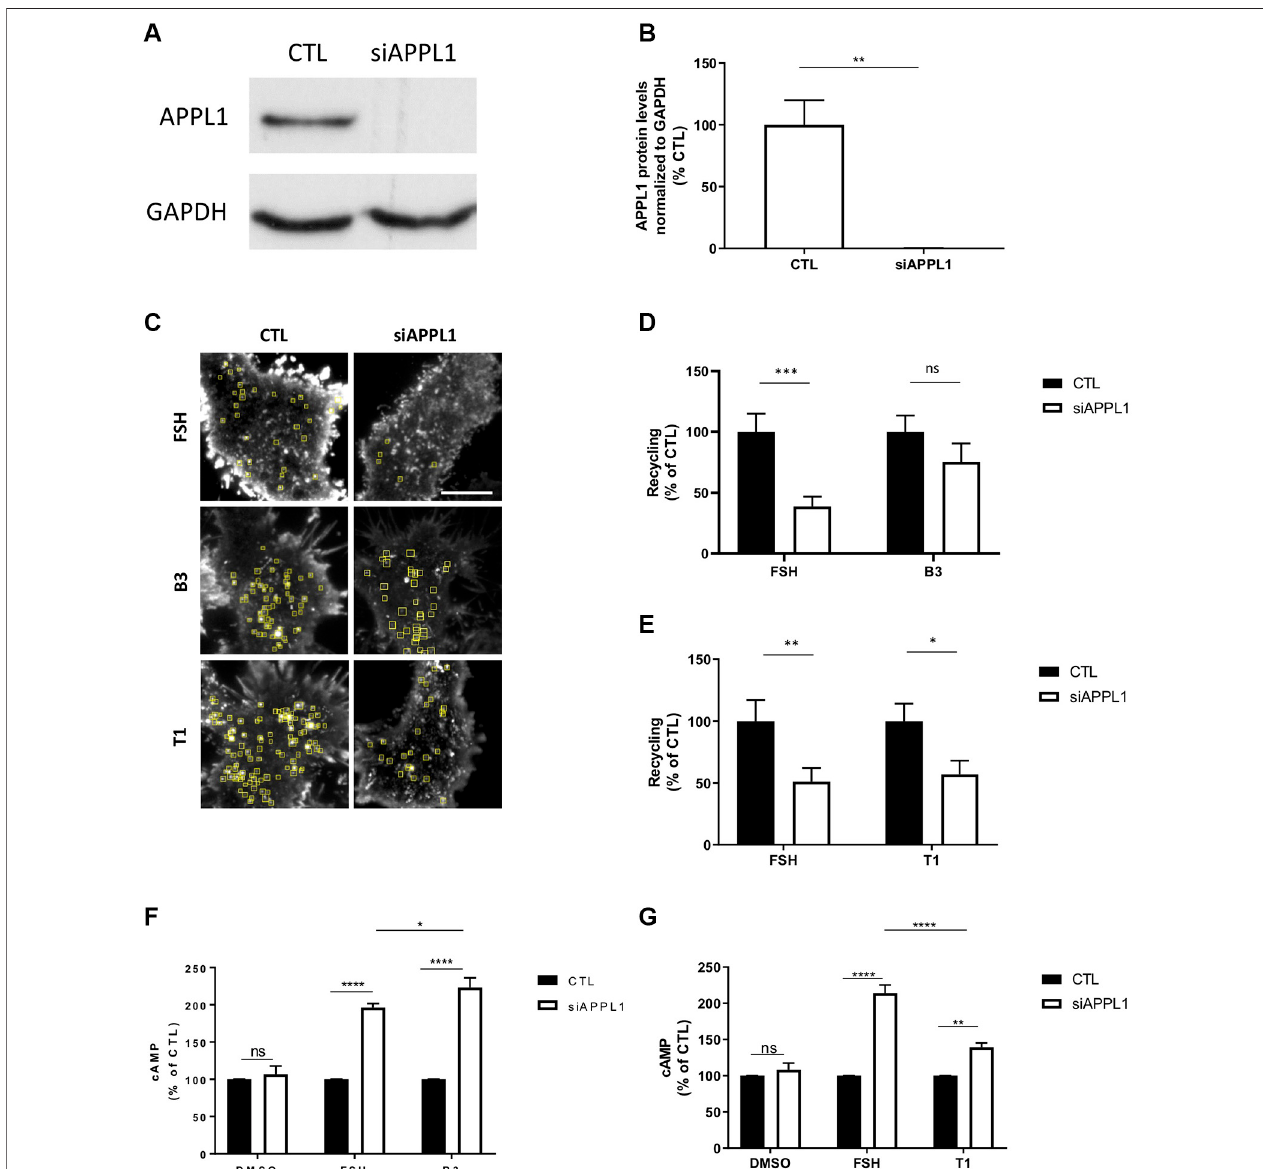
FIGURE 6 | LMW compoundsdifferentially affectAPPL1-regulated FSHR recyclingand cAMP signaling. (A) Western blotshowing total cellular levels of APPL1 from cells treatedwithscramble(CTL)orAPPL1siRNA(siAPPL1).GAPDHwasusedasaloadingcontrol. (B) Quanti fi cationofAPPL1proteinlevelsnormalizedtoGAPDHproteinlevelsfrom (A) ,andexpressedas%ofscramble,n (cid:2) 3independentexperiments, t -test:** p < 0.01. (C) MaximumintensityprojectionsfromSEP-FSHRexpressingcellsimagedlivebyTIR- FMfollowing transfection with either scramble(CTL)or APPL1siRNA(siAPPL1) and stimulated with either FSH (10 nM),B3or T1(10 μ M) for 5 – 20 min. Scalebar (cid:2) 5 μ m. (D – E) Quanti fi cation of the number of FSHR recycling events. n (cid:2) 21 – 24 cells per condition collected across four independent experiments for (D) and n (cid:2) 13 – 18 cells per conditioncollectedacrossthreeindependentexperimentsfor (E) .Two-wayANOVA:* p > 0.05,** p < 0.01,*** p < 0.001. (F,G) IntracellularlevelsofcAMPmeasuredincellsstably expressingFLAG-FSHRfollowing transfection witheitherscramble(CTL) or APPL1 siRNA (siAPPL1). Cellswerestimulated witheither DMSO, FSH(10 nM)orB3(10 μ M) (F) or DMSO, FSH (10 nM) or T1 (10 μ M) (G) for 5 min. n (cid:2) 5 (F) or 3 (G) independent experiments. Two-way ANOVA: * p < 0.05, ** p < 0.001 **** p <